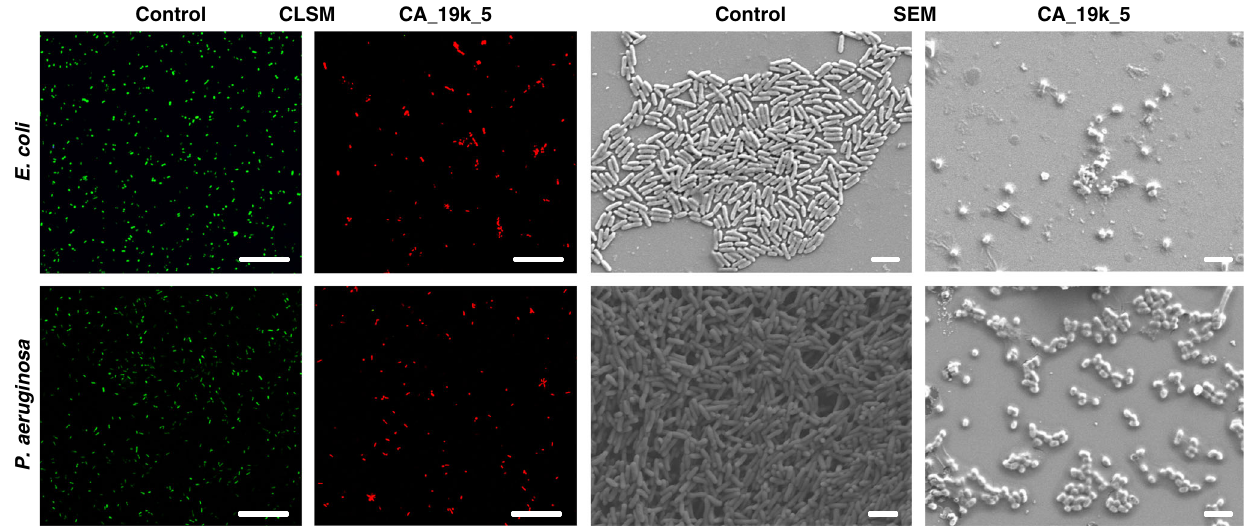
Fig. 7 CLSM and SEM images of E. coli and P. aeruginosa under control and CA_19k_5 treatment with two times of MIC concentration. Bacteria concentrations were 1.0 × 10 6 CFU/mL. Bacterial solutions without CA_19k_5 were used as the control. Scale bar in confocal images is 25 µ m and scale bar in SEM images is 2 µ